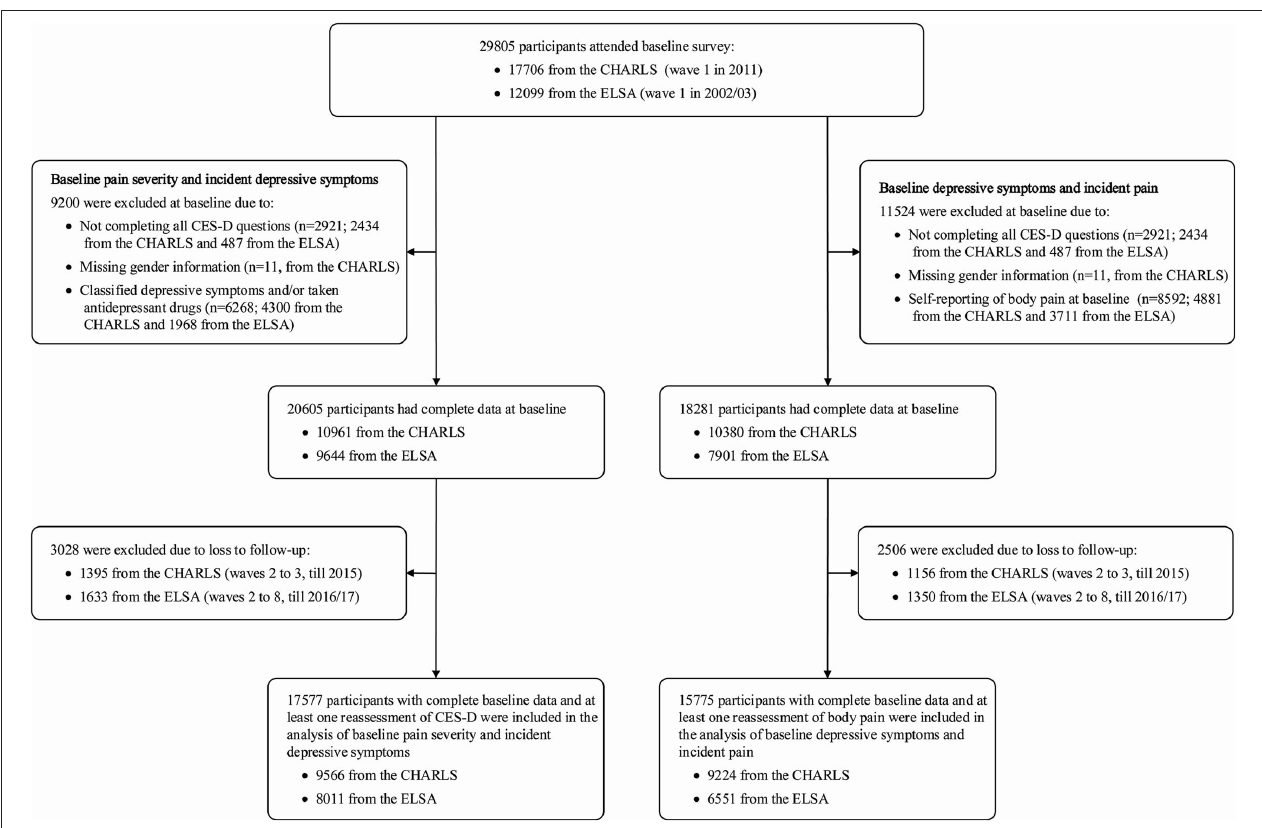
FIGURE 1 | Flow chart of inclusion of this study